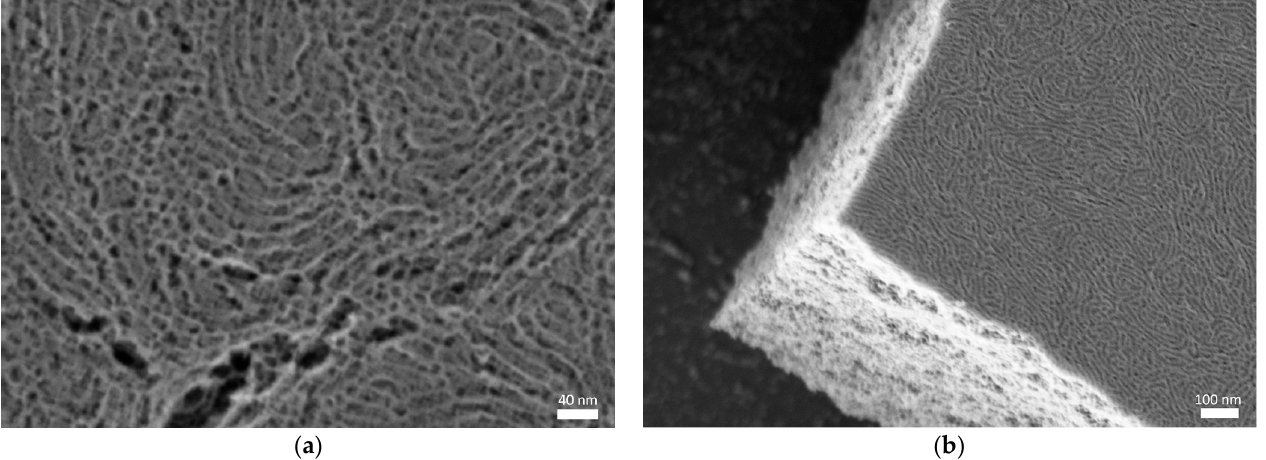
Figure 1. HRFESEM images of fabricated P123-templated mesoporous TiO 2 layers. ( a ) Top view of a monolayer. ( b ) Cross section of a multilayer where the deposition and aging processes are repeated three times before the final thermal treatment.